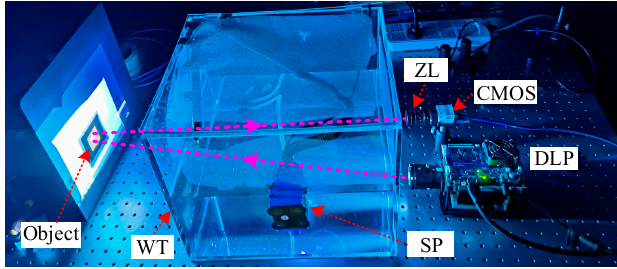
Figure 6. Experimental setup. ZL, zoom lens.